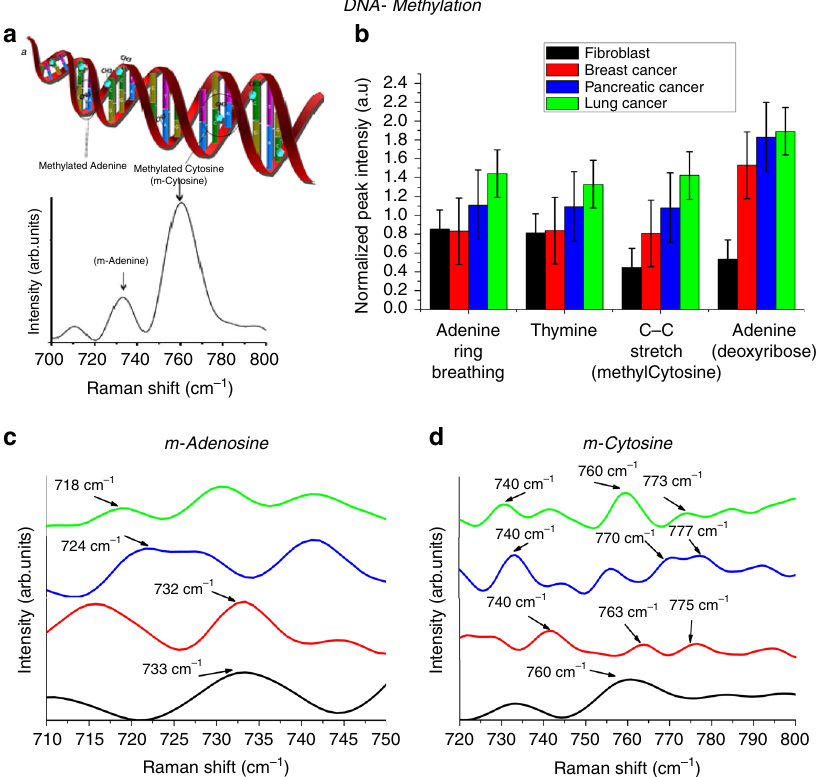
Fig. 6 Methylation analyses of genomic DNA. a Schematic representation of DNA methylation analysis using QOS. b DNA methylation markers to determine global hypermethylation in the genomic DNA isolated from fi broblast, Breast cancer, pancreatic cancer, lung cancer cells, detailed SERS spectra of the region 700 – 800 cm − 1 providing the markers for c methyl – cytosine, d methyl –